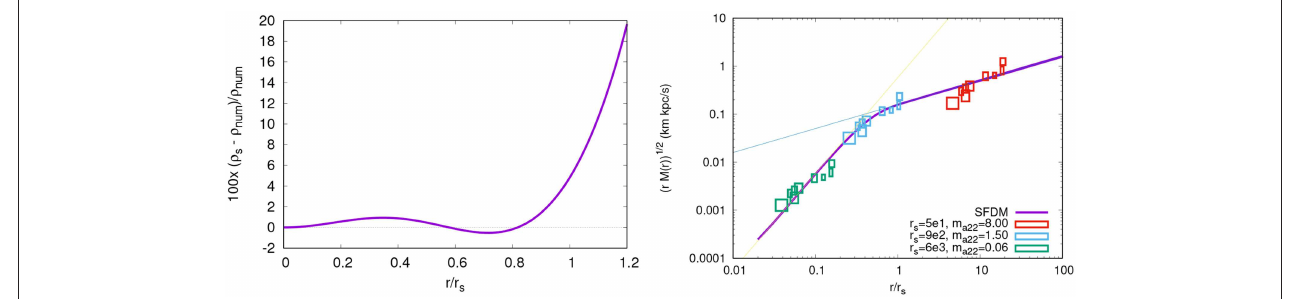
FIGURE 4 | (Left) Comparison between the numerical (see section 3.3) and semianalytical (see Equation 25) profiles of the density ρ stationary equilibrium configuration. Notice that the relative error between the two cases is less than 4 % up to r enormously because the numerical profile decays exponentially. (Right) The observable quantity [ rM ( r )] 1 / 2 , see Equation (27), calculated from the corresponding quantities reported in Fattahi et al. (2016) of the eight classical Milky Way dwarf spheroidals. The observable is scale invariant, see Equation (13), but the colors of the error boxes indicate the corresponding different values of the boson mass m a and the soliton radius r s . The magenta curve represents the complete profile of the observable, whereas the yellow and cyan straight lines indicate the asymptotic behaviors at small (